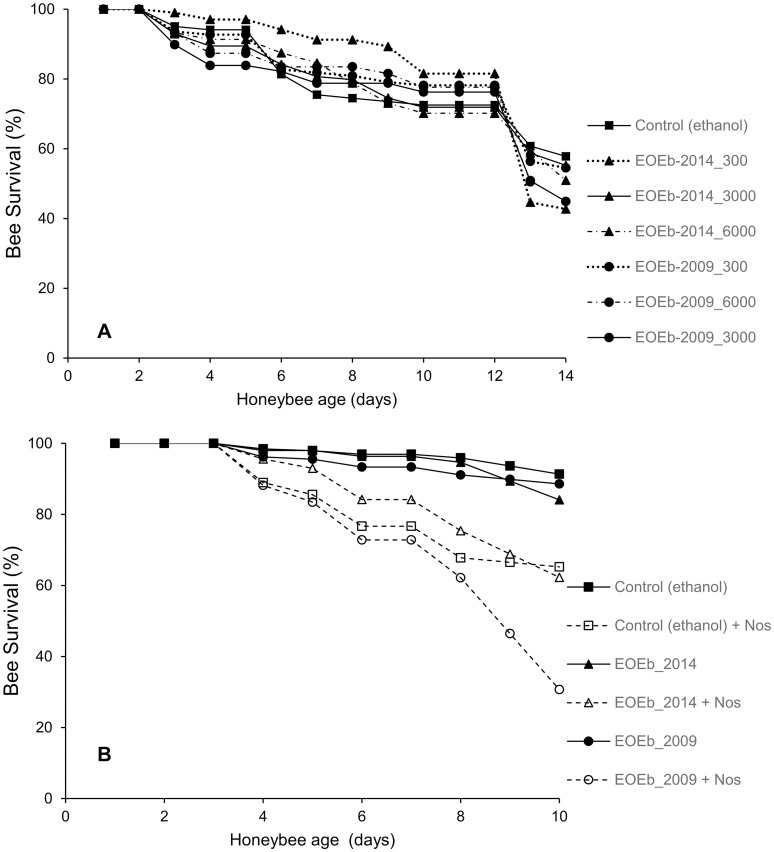
Survival of honeybees fed on diets enriched with E. buniifolium EO.EOs produced at different harvest times (2009 and 2014) were tested: on healthy honeybees at different doses (A) and on healthy (solid symbols) and Nosema-infected (open symbols) honeybees at 3000 ppm (B). For healthy bees (A), no differences were found among honeybees fed with the EOEb at different doses (ANOVA, GLM, p = 0.65 for treatment and p = 0.13 for the interaction treatment*time), and survival decreased with time (p < 0.05). For Nosema-infected honeybees (B), significant differences (ANOVA; GLM) were found related to health status (P < 0.001) and time (P < 0.001) but not related to diet (P = 0.6). Error bars are not shown for clearness of the figure.